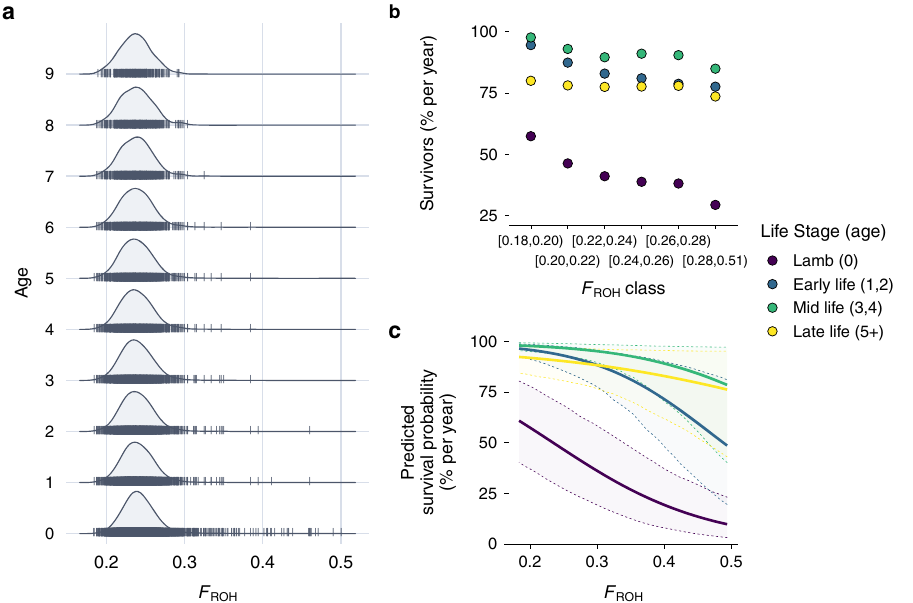
Fig. 3 Inbreeding depression in annual survival. a Distributions of inbreeding coef fi cients F ROH in Soay sheep age classes ranging from 0 to 9 years. b Proportion of surviving individuals per year in four different life stages and among different F ROH classes. As highly inbred individuals are relatively rare, the last class spans a wider range of inbreeding coef fi cients. Source data for this fi gure are also provided as a source data fi le. c Predicted survival probability and 95% credible intervals over the range of inbreeding coef fi cients F ROH for each life stage while holding sex and twin constant at 1 (male) and 0 (no twin). The predictions for the later life stages classes exceed the range of the data but are shown across the full range for comparability.